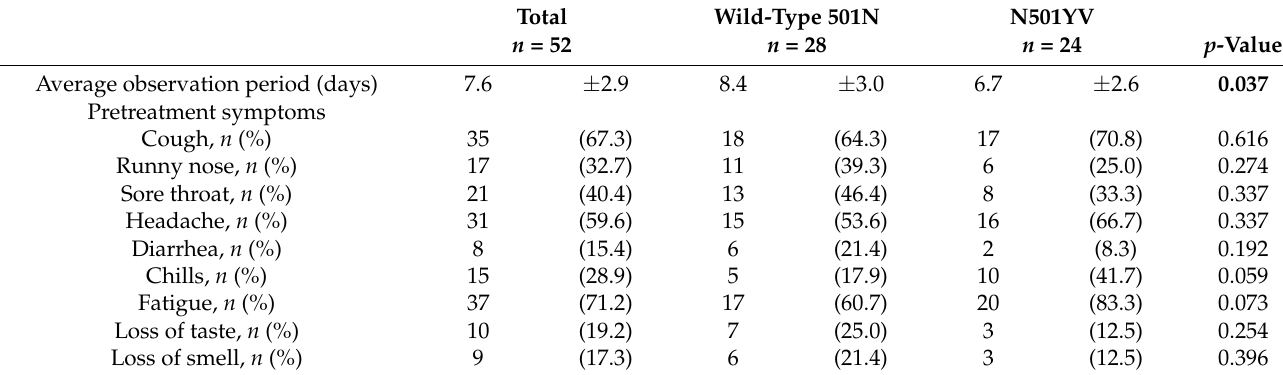
Table 3. Pre-treatment symptoms of the patients infected with wild-type 501N and N501YV. ( n =